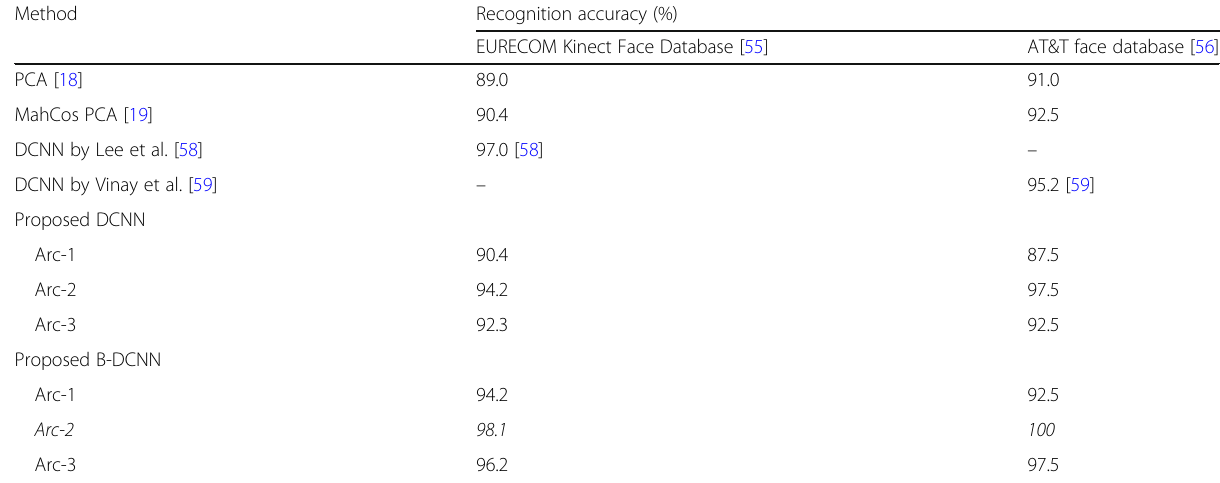
Table 2 Summary of